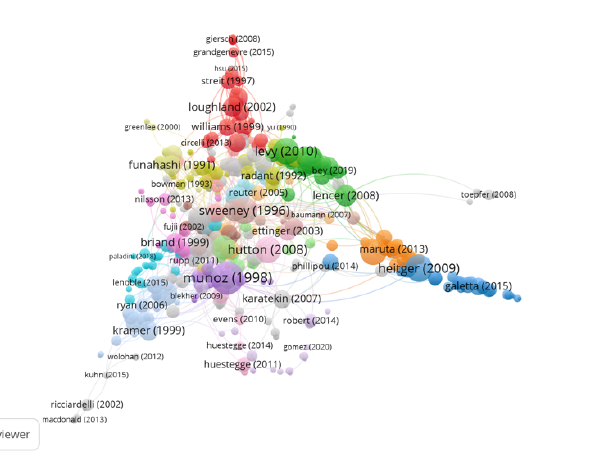
Figure 4. Citation network in Group 2